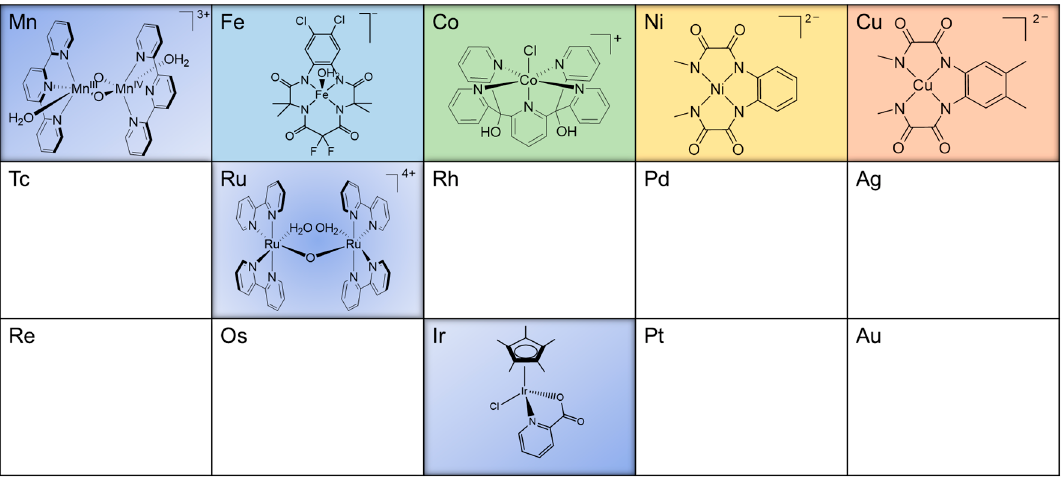
Figure 2. The 3d (Mn, Fe, Co, Ni, and Cu), 4d (Ru), and 5d (Ir) metals in the periodic table that have been incorporated in the design of synthetic bio-inspired molecular catalysts for water oxidation. Key examples of the catalysts that have been developed for each metal are also shown.